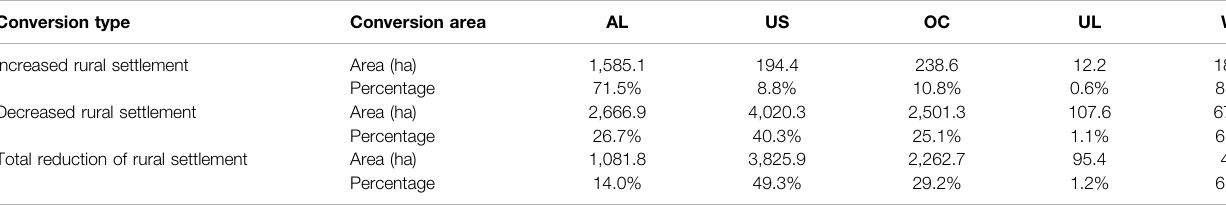
TABLE 3 | Conversion structure between rural settlement and other land-use types in 2000 and